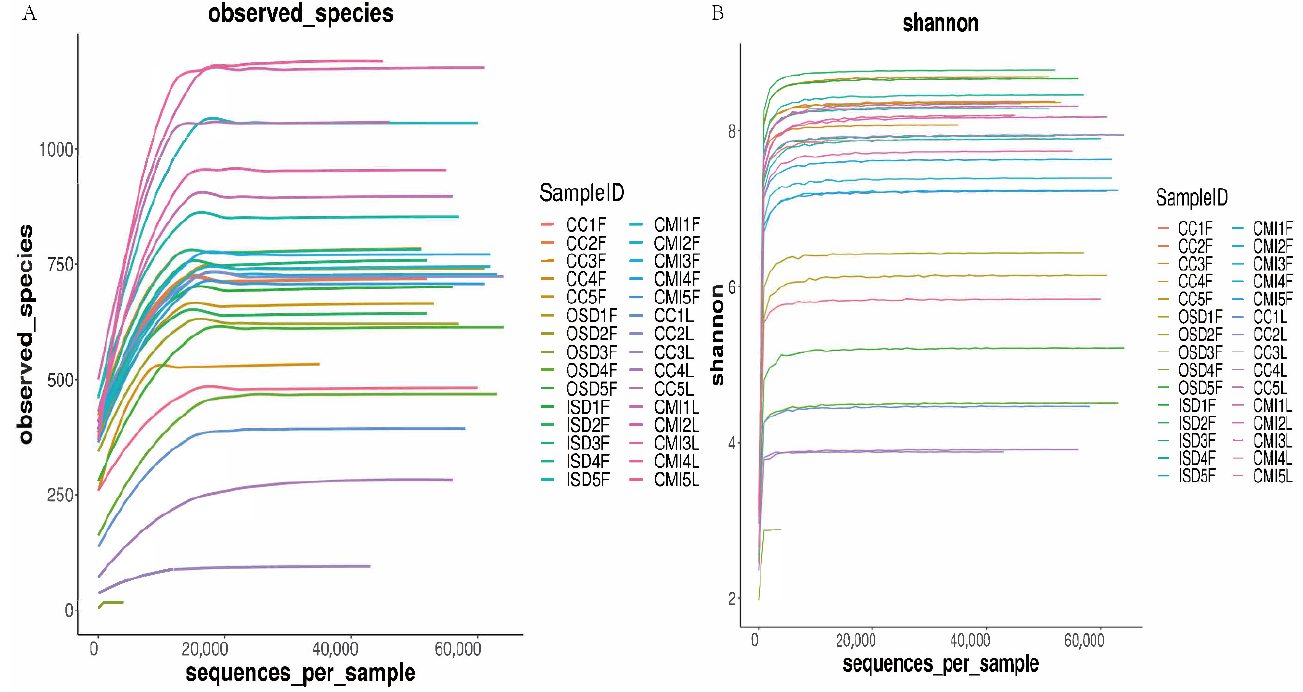
Figure 2. Rarefaction curves of observed species ( A ) and Shannon diversity index ( B ) for group tick samples.